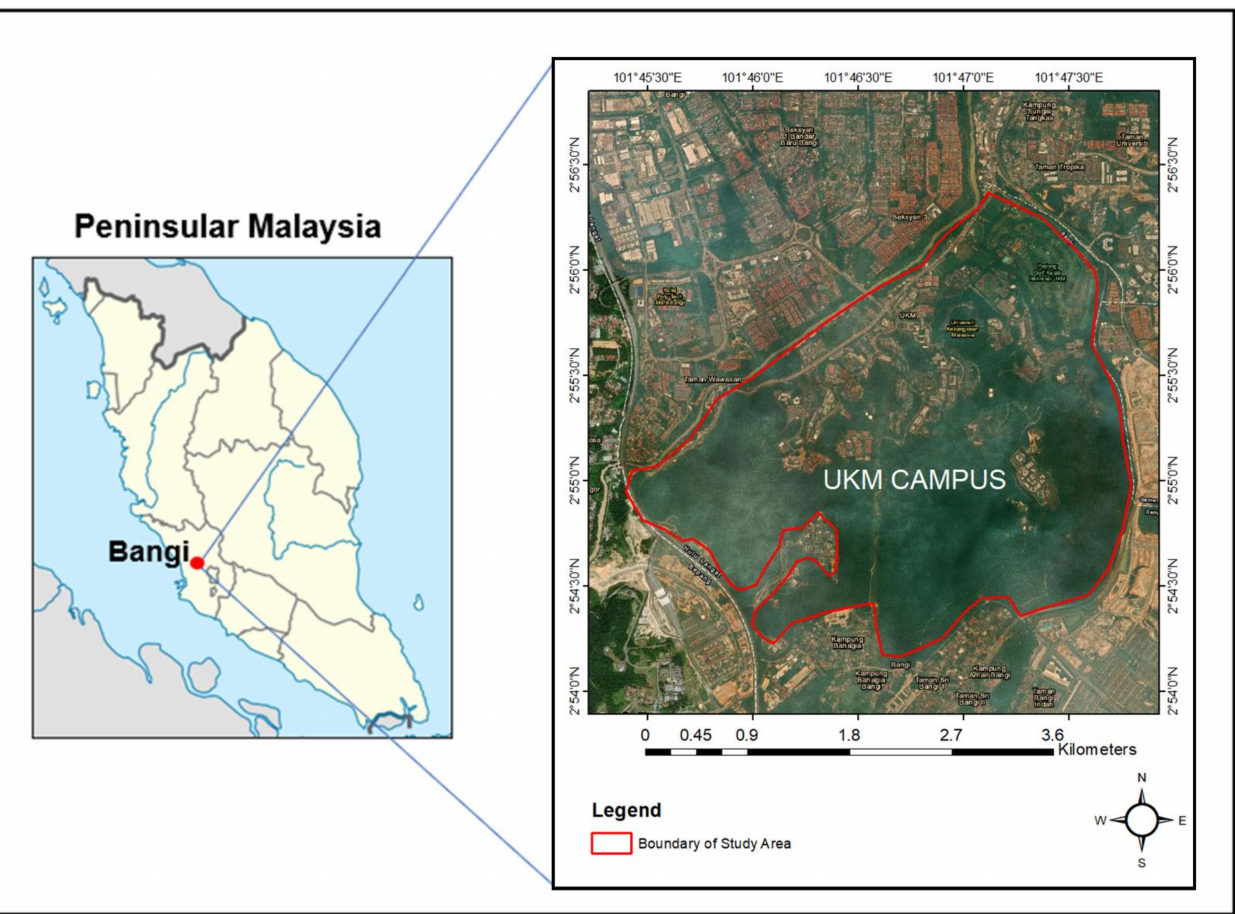
Figure 2. Map of the study